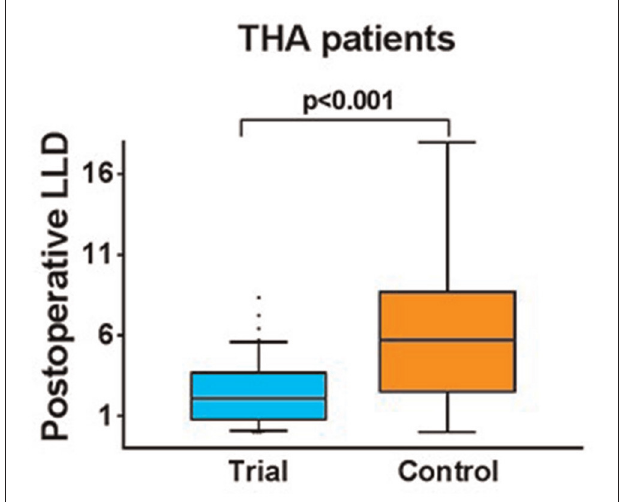
FIGURE 2 | Comparison of postoperative LLD between group I and group II.